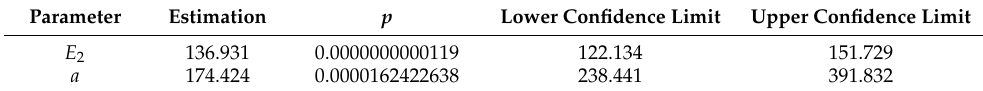
Table 4. Pillar parameters set for the elastic model using the Statistica v. 10 program.